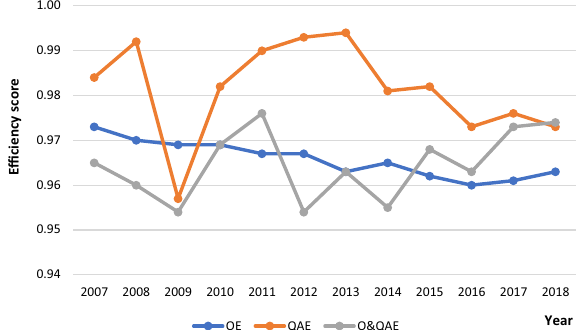
Fig. 1 Evolution over time of the ef fi ciency of the Chilean water utilities. The trend in different types of ef fi ciency. OE operational ef fi ciency, QAE quality adjusted ef fi ciency, O&QAE operational & quality adjusted ef fi